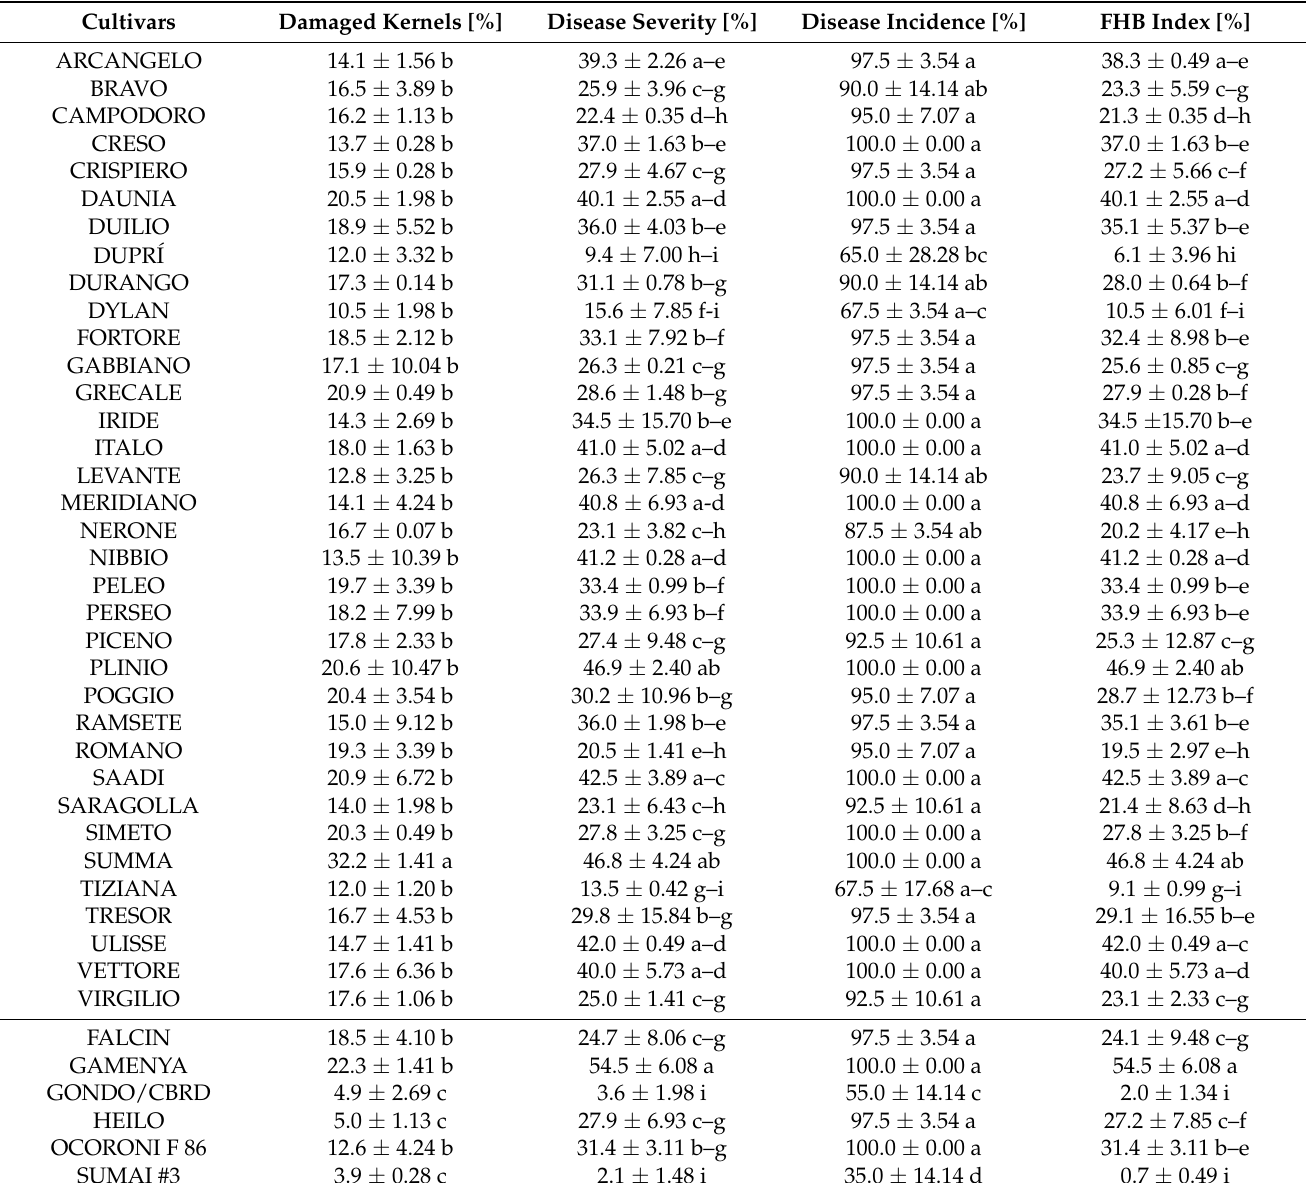
Table 1. Susceptibility to Fusarium head blight (FHB) of 35 Italian durum wheat cultivars and six bread wheat cultivars used as references, artificially inoculated with Fusarium graminearum , as evaluated at CIMMYT, Mexico and expressed in terms of proportion of damaged kernels, disease severity, disease incidence and FHB index 1